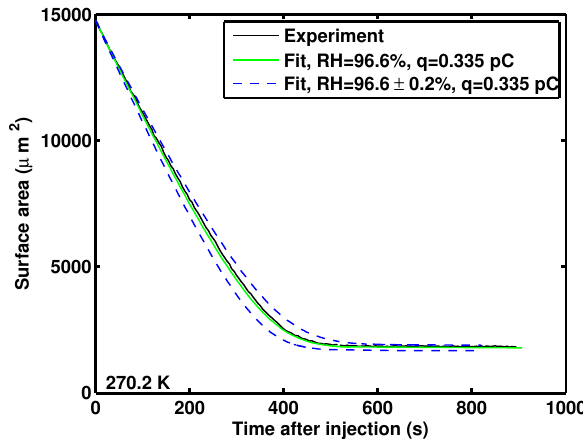
Fig. 4. Example of measured surface area (black curve) of a charged evaporating particle as function of time. The green curve is the analytical solution to Eq. (5). The dashed blue curves illustrate the result of varying the RH value ± 0.2%, which is the estimated uncertainty of the relative humidity.